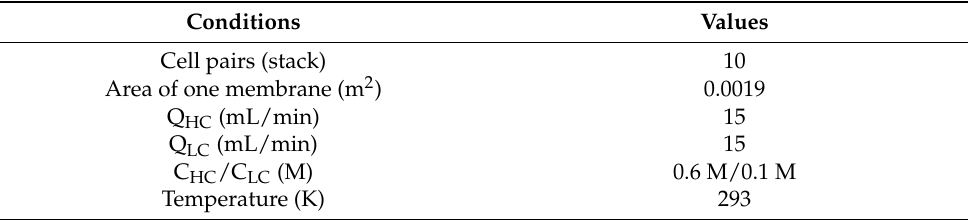
Figure 1. ( a ) Schematic diagram of RED experimental equipment; and ( b ) photography of the experimental setup. Table 1. Operating conditions for RED experiments.